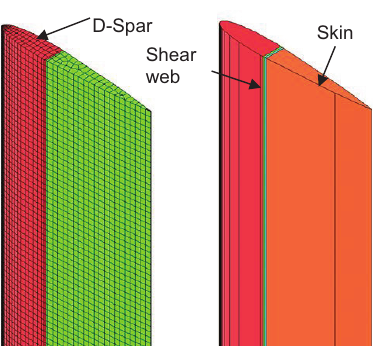
Figure 6. Tip deflection vs. Tip